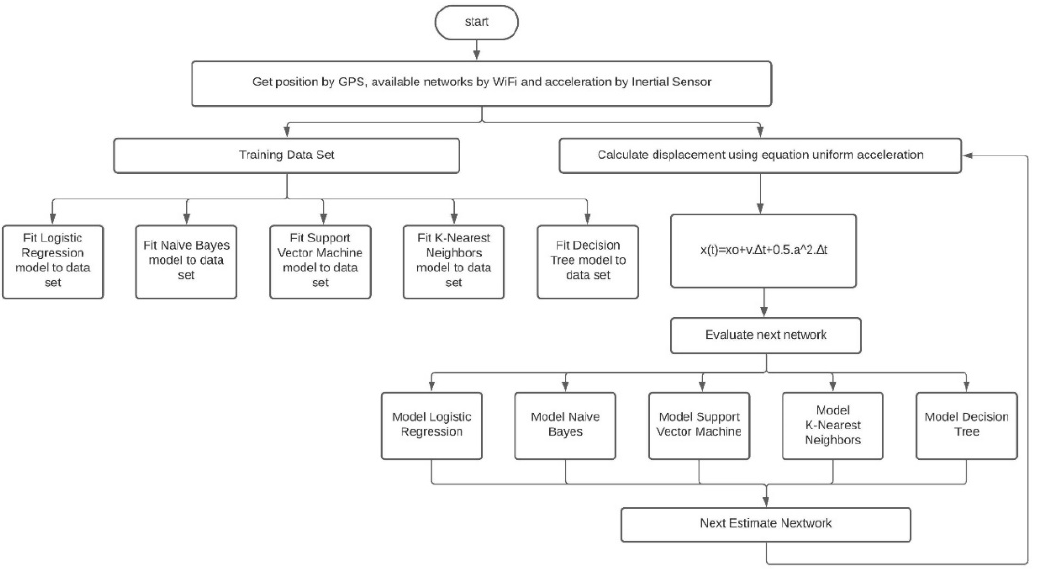
Figure 5. System flow diagram.